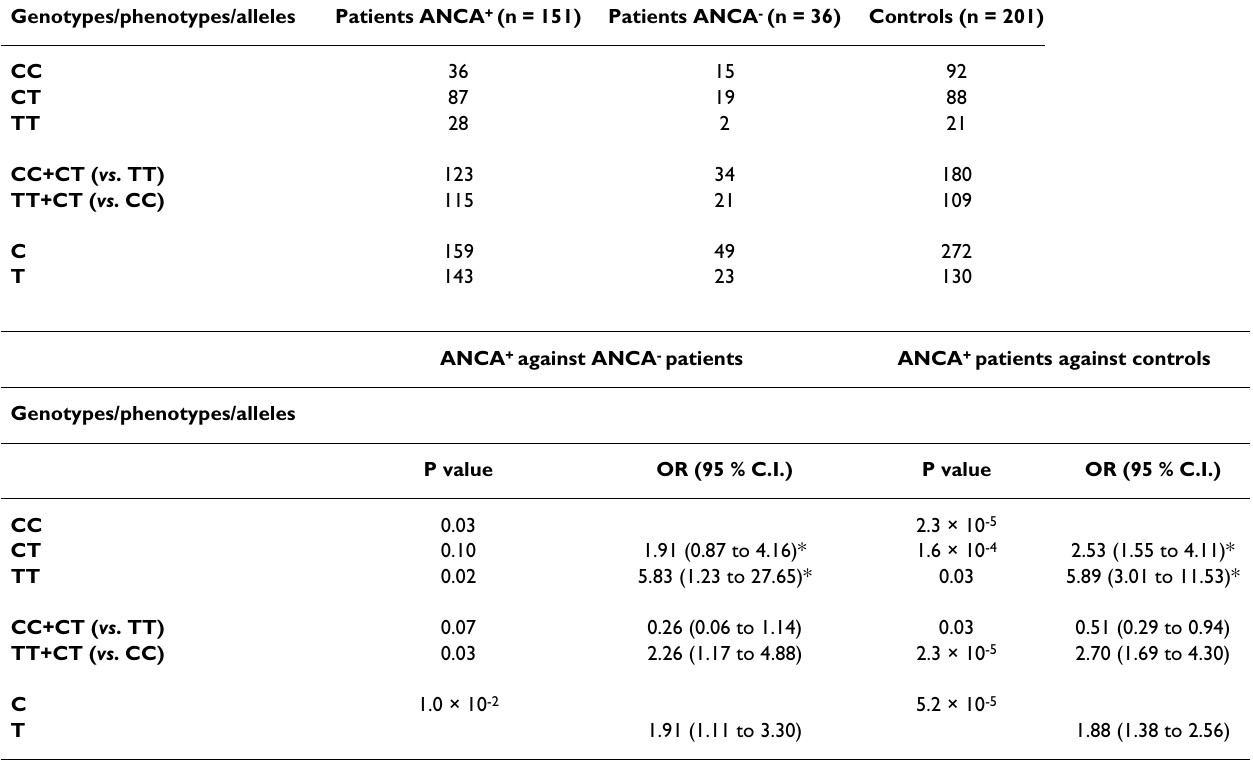
Table 3: Genotyping of rs6531 in the RXRB gene. Genotypes/phenotypes/alleles